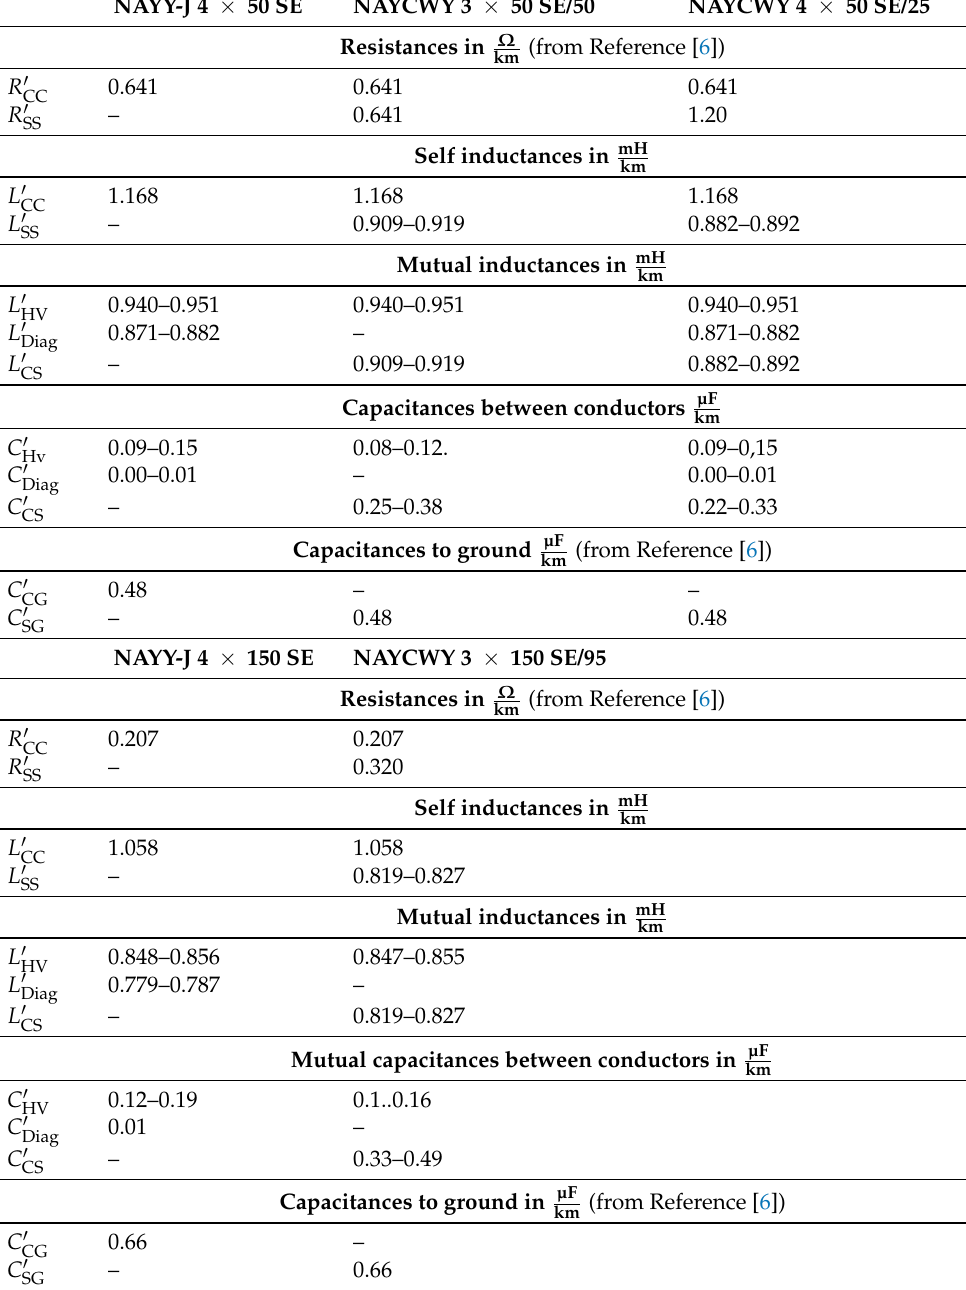
Table A1. Model parameters acc. Section 4, calculated for ϑ = 20°C. Datasheets: Refs.